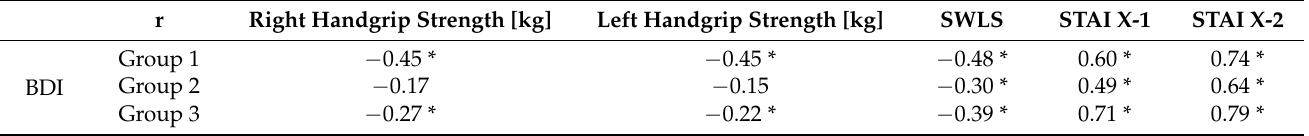
Table 8. The correlation (r coefficient) between BDI and handgrip strength, SWLS, and STAI in three groups. r Right Handgrip Strength [kg] Left Handgrip Strength [kg]